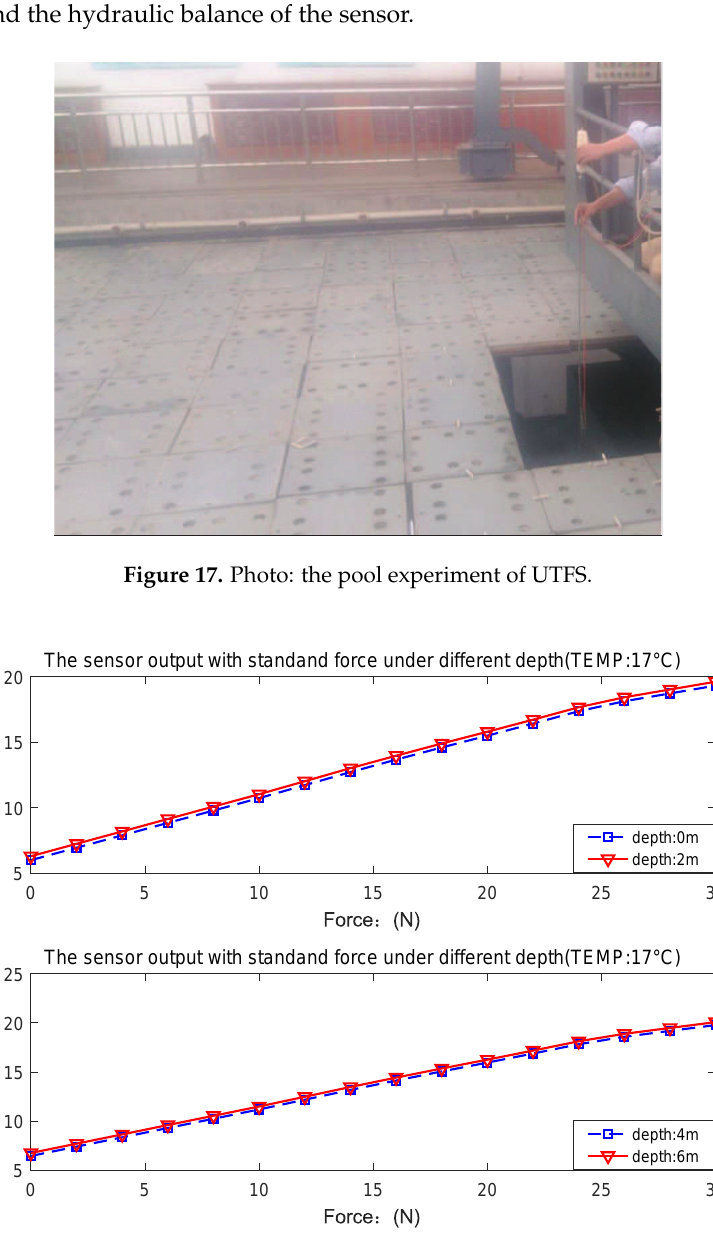
Figure 18. UTFS output with standard force loading at different